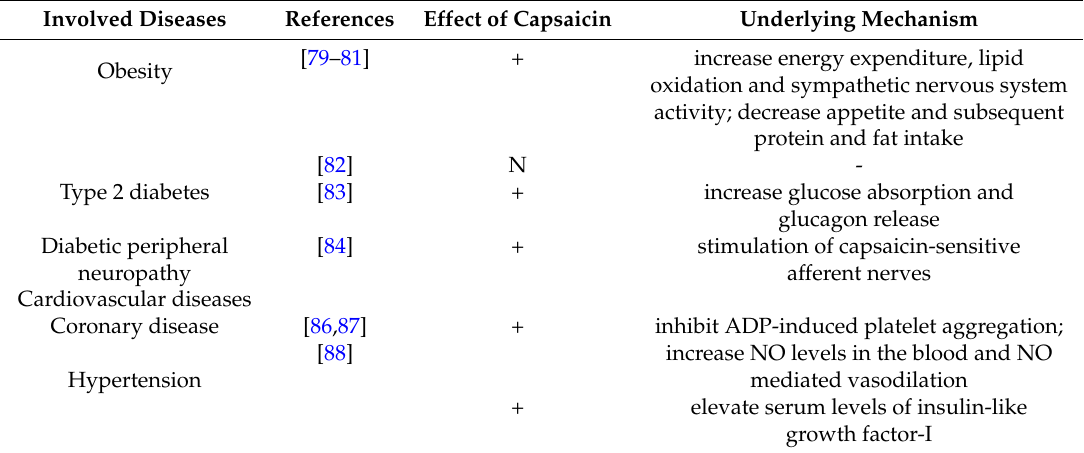
Table 1. The effects of capsaicin on cardiometabolic diseases in human